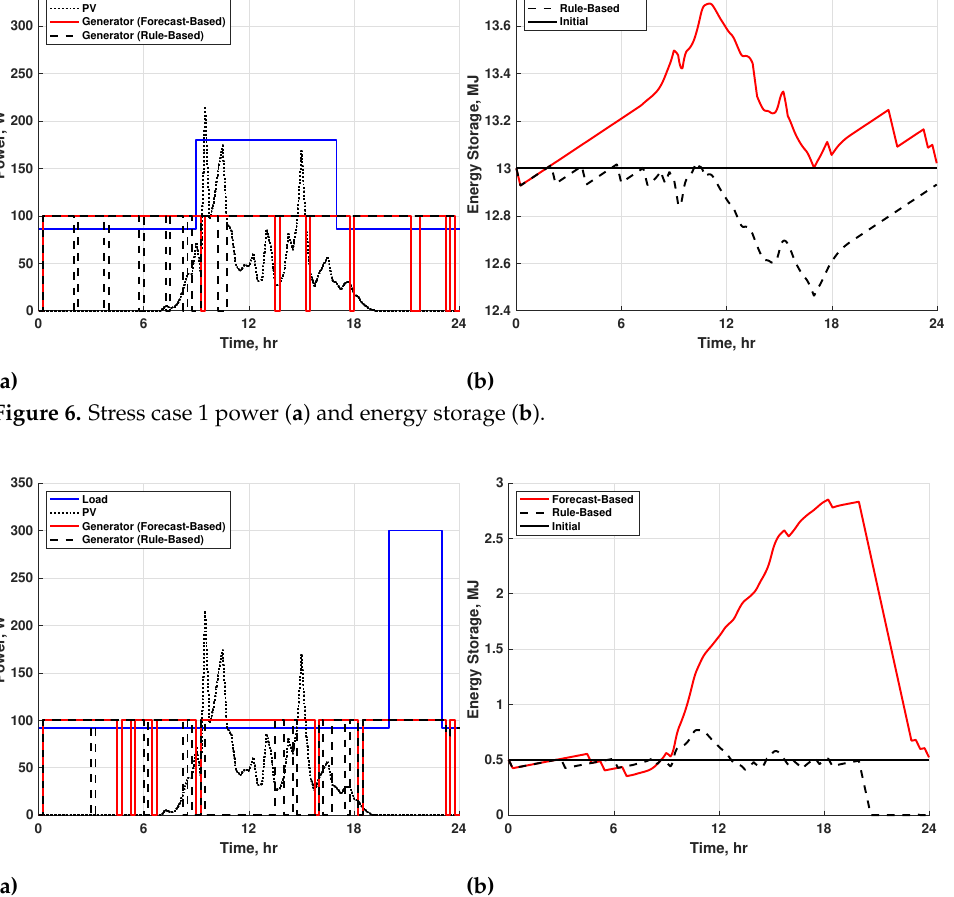
Figure 7. Stress case 2 power ( a ) and energy storage ( b